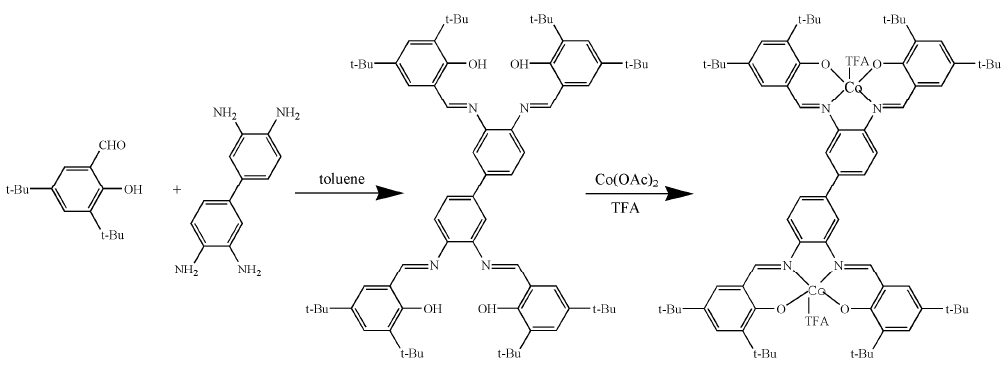
Figure 1. (Salen)Co(III)X catalyst for PO/CO 2 copolymerization (X = Cl, DNP, TFA).